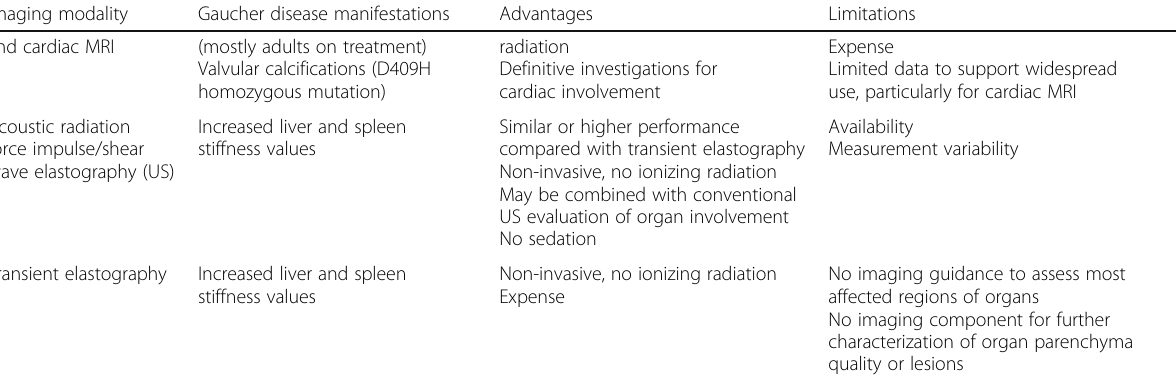
Table 4 Imaging modalities relevant to Gaucher disease (Continued) Imaging modality